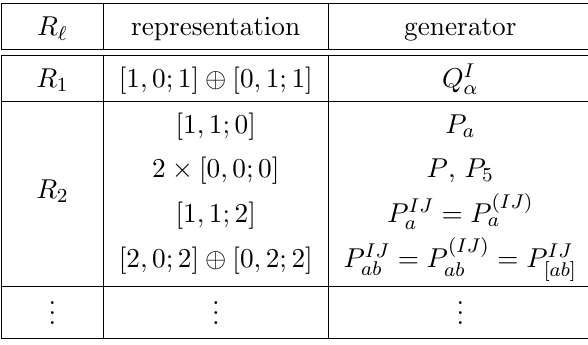
The free Lie superalgebra f ( Q ) in D = 4 space-time dimensions for extended N = 2 supersymmetry. The su (2) R-symmetry representation is given by the last Dynkin label while the (cid:12)rst two specify the A 1 (cid:8) A 1 representation. The fundamental R-symmetry index is I = 1 ;